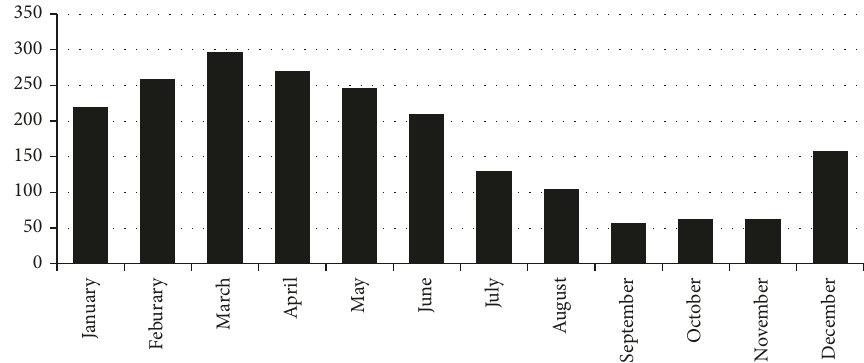
Figure 1: Seasonal distribution of 2073 Haemophilus influenzae strains isolated from six Chinese hospitals in 2016. Table 1: Antibiotic resistance of 2073 Haemophilus influenzae strains isolated from patients in six children’s hospitals in China in 2016.